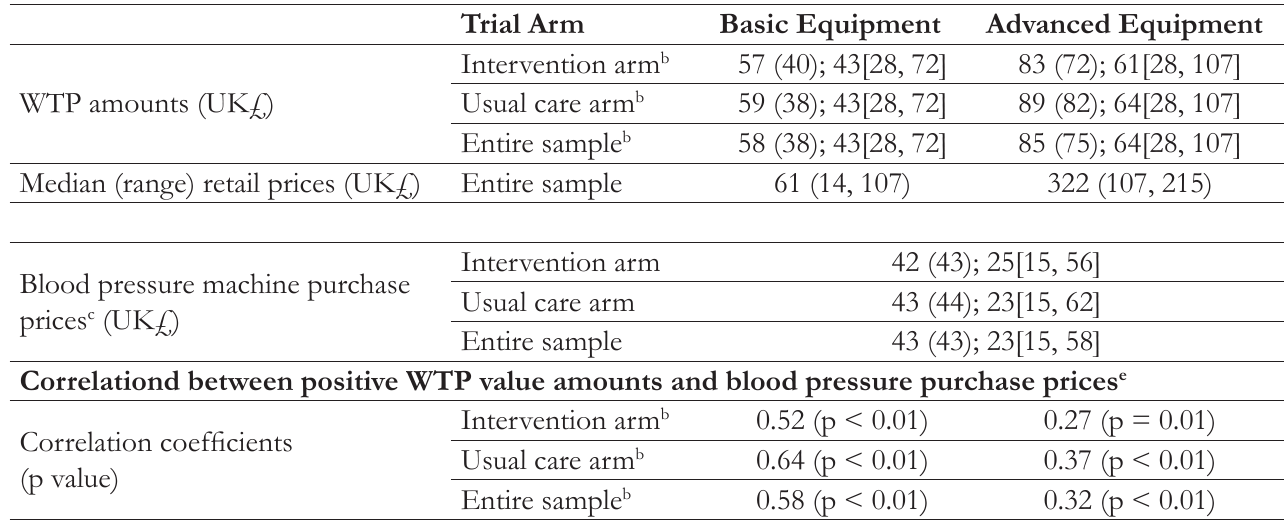
Distribution of willingness to play values, measured in UK pounds 2015 prices, for basic (a) and advanced (b) equipment. They show that willingness to pay values for both types of equipment were right skewed. Table 2. WTP Amounts, Blood Pressure Machine Purchase and Retail Prices (2015 UK£)